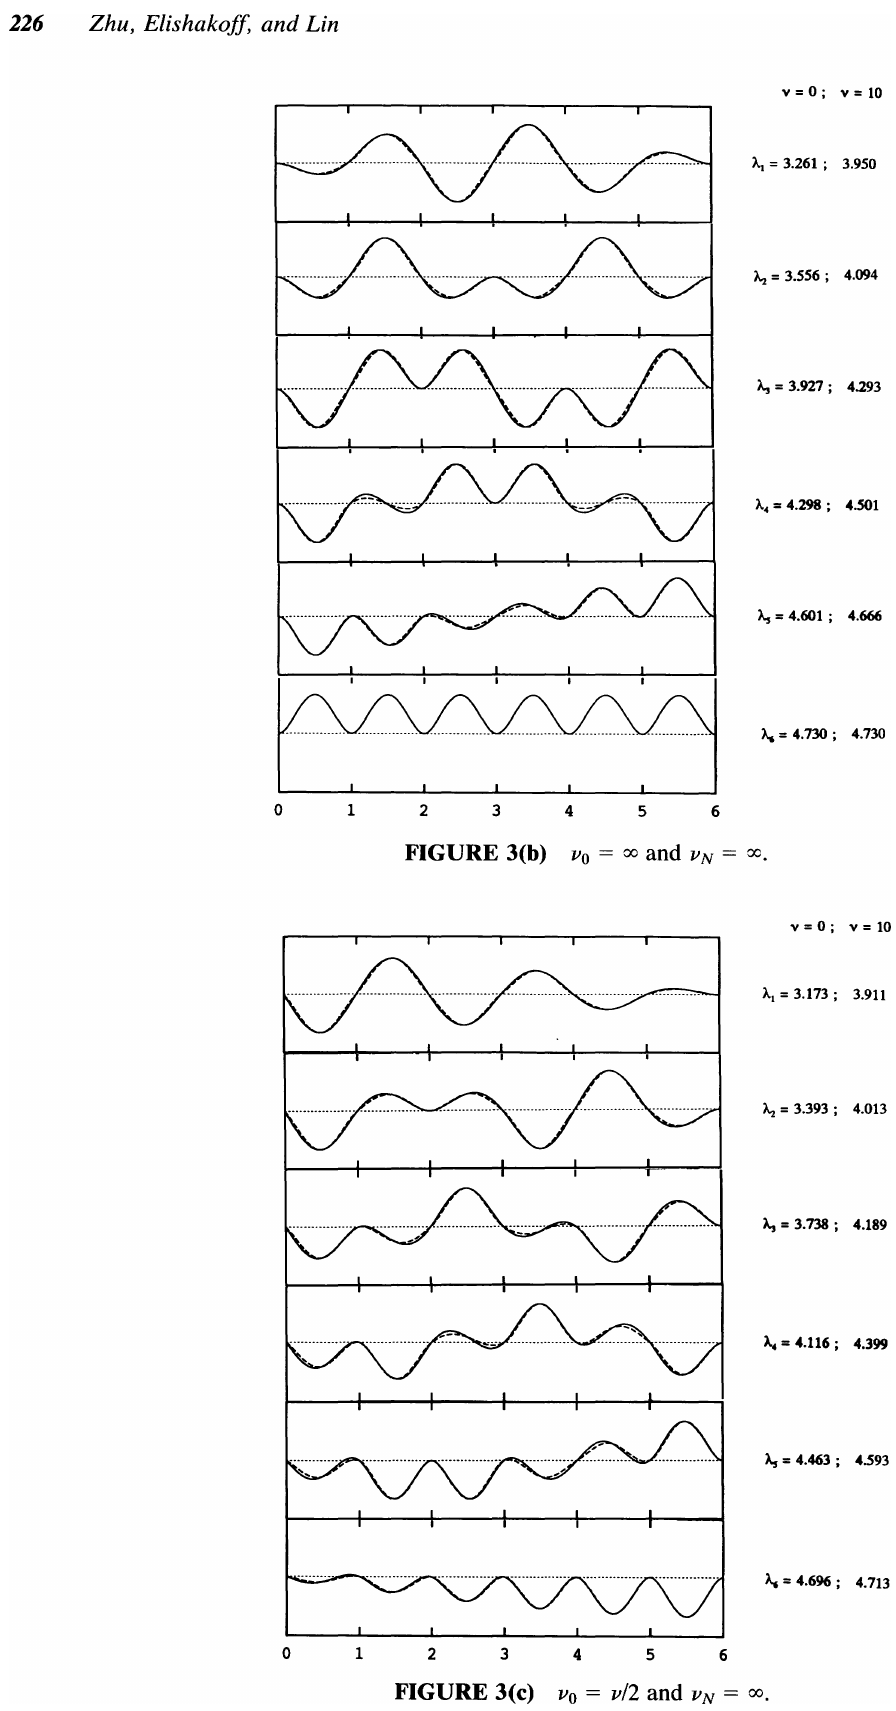
FIGURE 3(c) Vo = vl2 and VN =